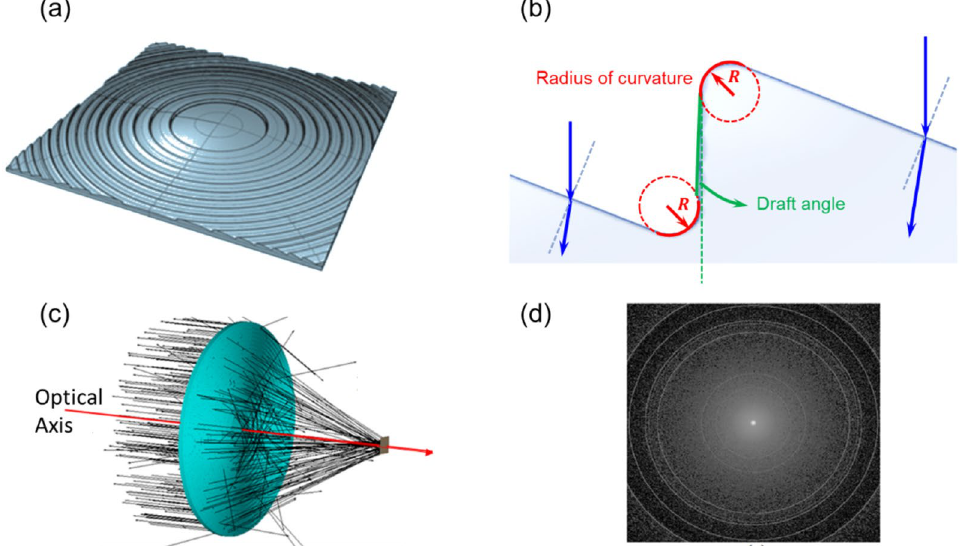
Figures 1. Schematic diagram of the Fresnel lens structure and the simulated beam propagation. ( a ) The structure of the Fresnel lens. ( b ) The diagrammatic sketch represents the zoom-in image of the grooves in Fresnel lenses. ( c ) Ray-tracing simulation and a set of ray fans of the Fresnel lens. ( d ) The simulated optical flux distribution across the focal plane. The illuminance shown outside the focusing area came from the leakage